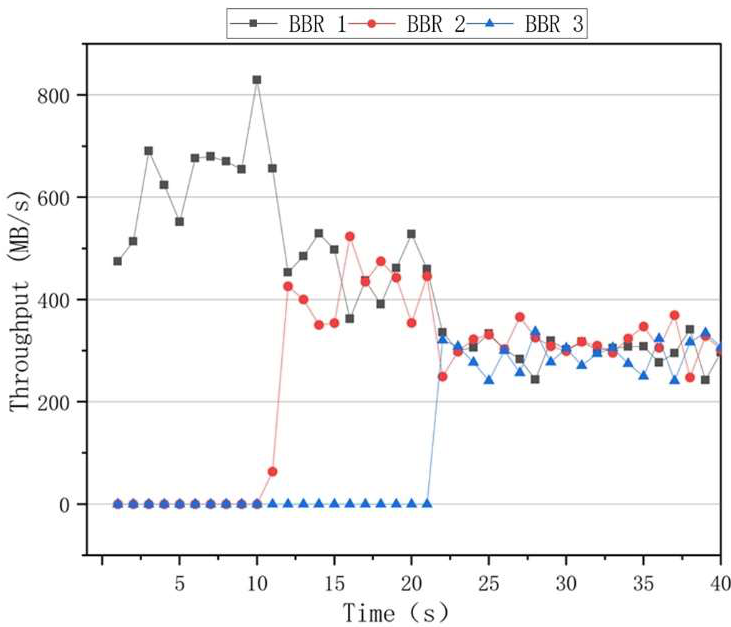
Figure 10. The fairness curves of the BBR congestion control algorithm at a network delay of 100 ms and a packet loss rate of zero.